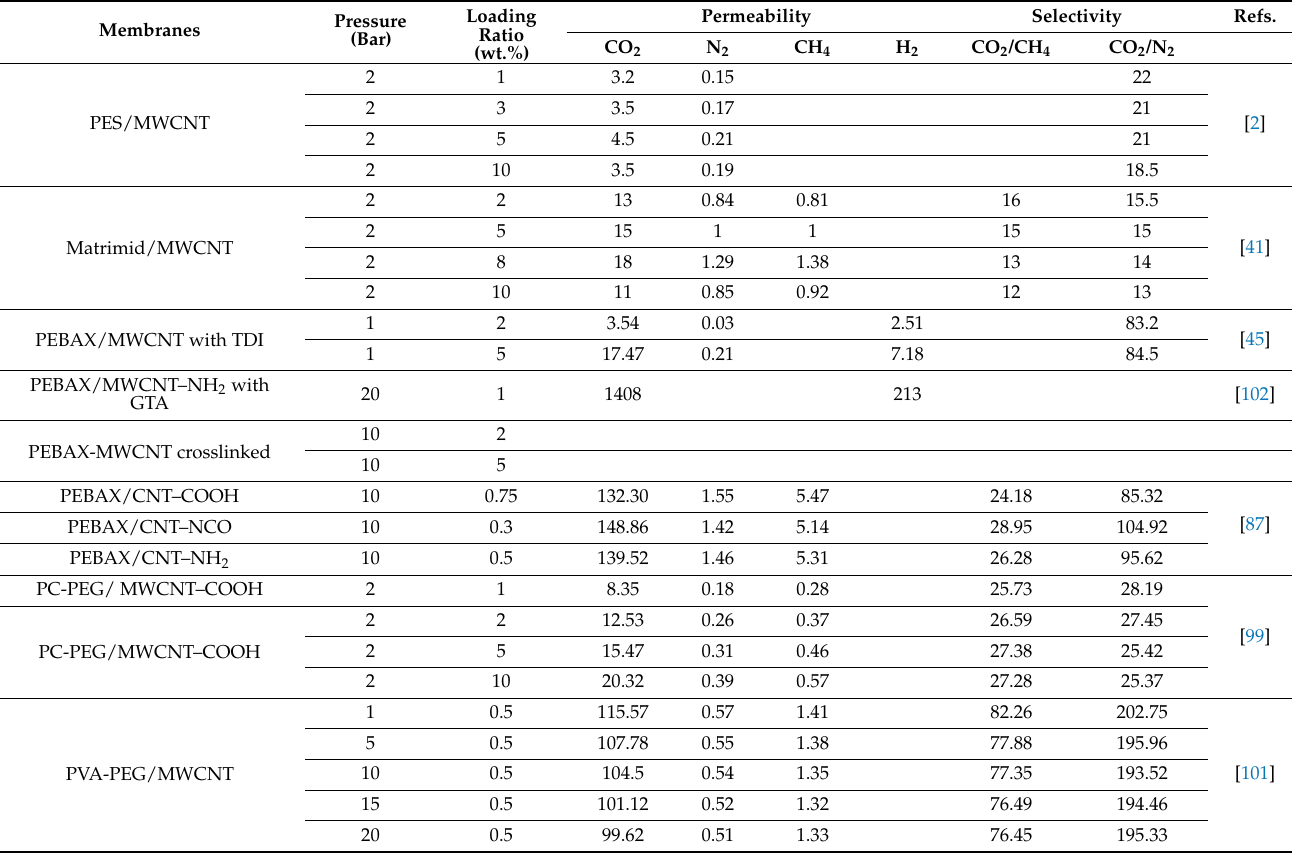
Table 5. Different MMMs’ permeability and selectivity in gas